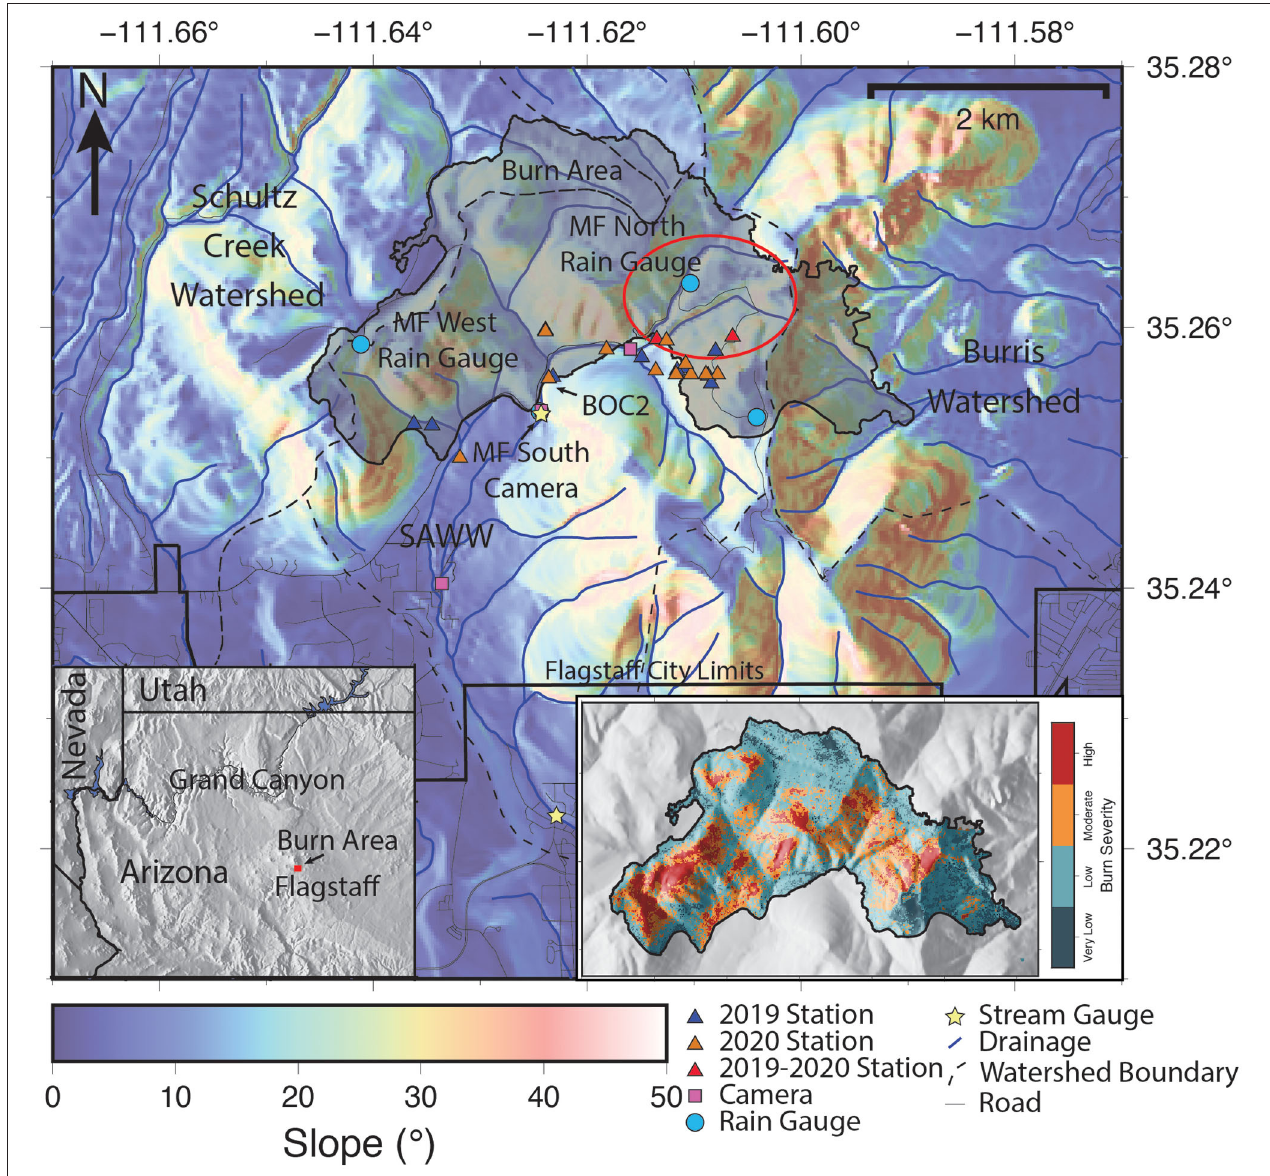
FIGURE 1 | Hillslope map of the study area showing the burn area and the location of seismic stations, monitoring cameras, stream gauges, and rain gauges. Labels are provided for site where data are shown in Figure 2 . Red circle denotes the area where debris flows initiated during the July 24, 2020 event. Inset show burn severity map modified from Museum Fire BAER Team